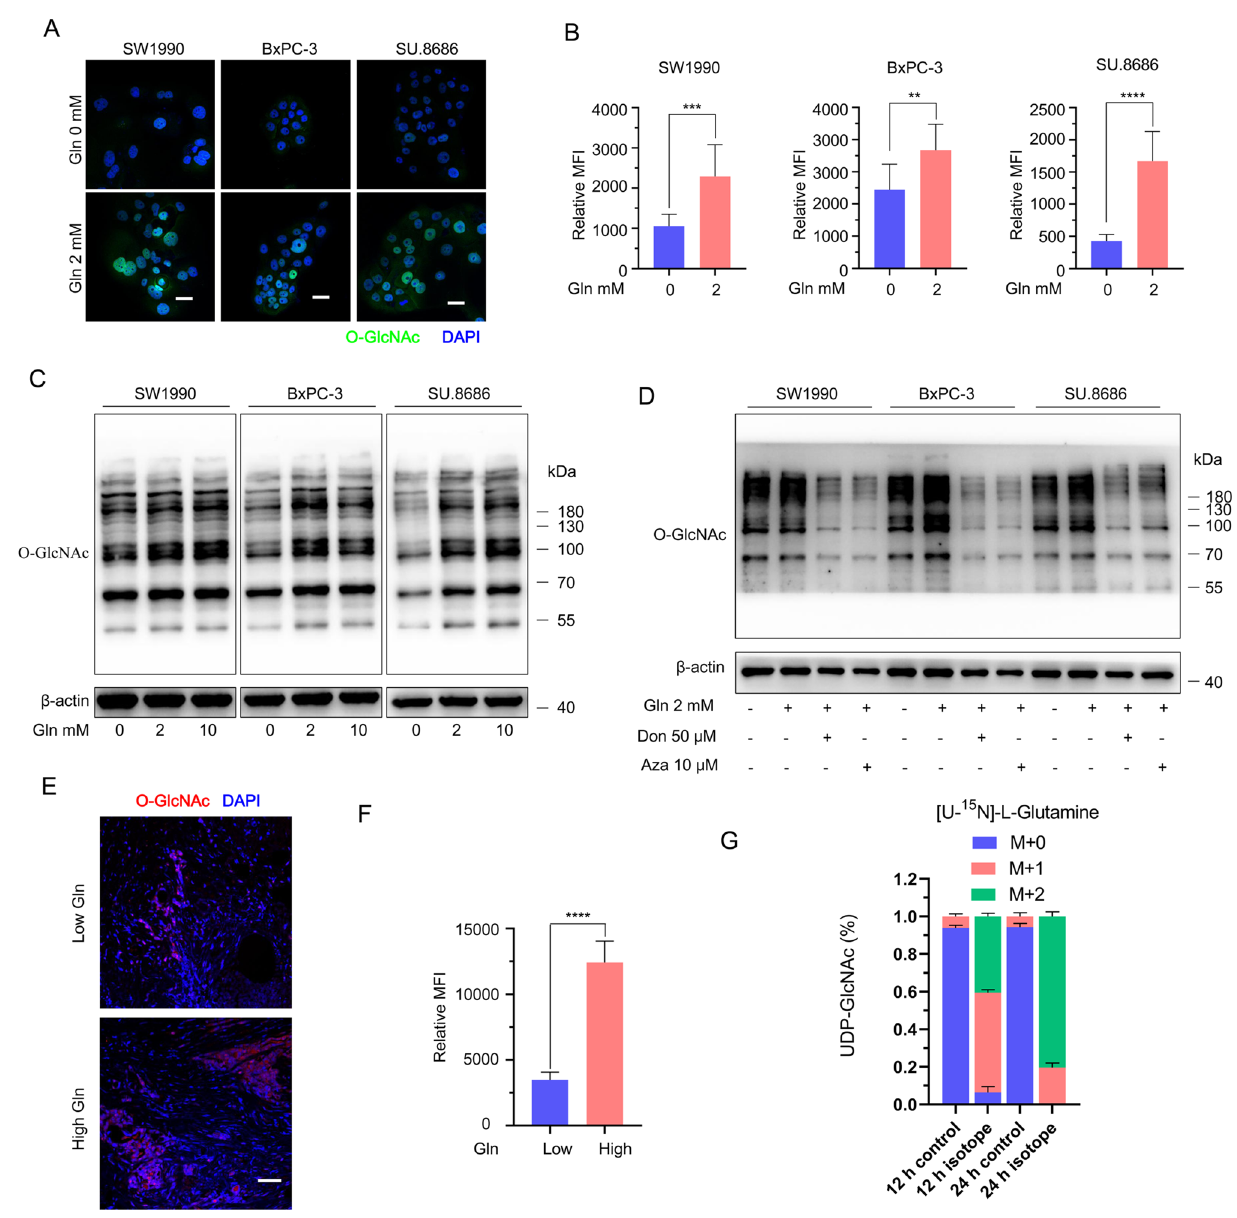
Fig. 4 Glutamine promotes O-GlcNAc biosynthesis. A, B The addition of 2 mM glutamine to glutamine-free medium increased the expres- sion of O-GlcNAc in SW1990, BxPC-3, and SU.8686 cells, as shown by immunofluorescence confocal microscopy. Cells were cultured in dif- ferent media for 72 h. Quantification is shown to the right. Data were randomly chosen in seven different fields. Scale bars, 25 μm. C The expression of O-GlcNAc in cells cultured in medium containing various concentrations (0, 2, 10 mM) of glutamine for 72 h was examined by Western blot. D The expression of O-GlcNAc in cells cultured for 72 h in glutamine-free medium, 2 mM glutamine medium, and 2 mM glu- tamine medium treated with 50 µM Don or 10 µM Aza was examined by Western blot. E , F Representative image ( E ) and quantification ( F ) of the expression of O-GlcNAc in high-glutamine pancreatic cancers versus low-glutamine pancreatic cancers as observed by immunofluores- cence in clinical samples. n = 6 cases in each group. Scale bars, 50 μm. G Fractional isotopomer labelling of UDP-GlcNAc from [U- 15 N]-L-glu- tamine after 12 h and 24 h using UHPLC-MS. All data are presented as the mean ± s.e.m. M + (M0, M1 to Mn) represents the number of C or N in metabolites labeled by isotopes. The fractional abundance of mass isotopomers defined by M0, M1, and Mn was calculated. Three repli- cates per condition . UHPLC-MS ultrahigh performance liquid chromatography coupled with tandem Q-Exactive Orbitrap mass